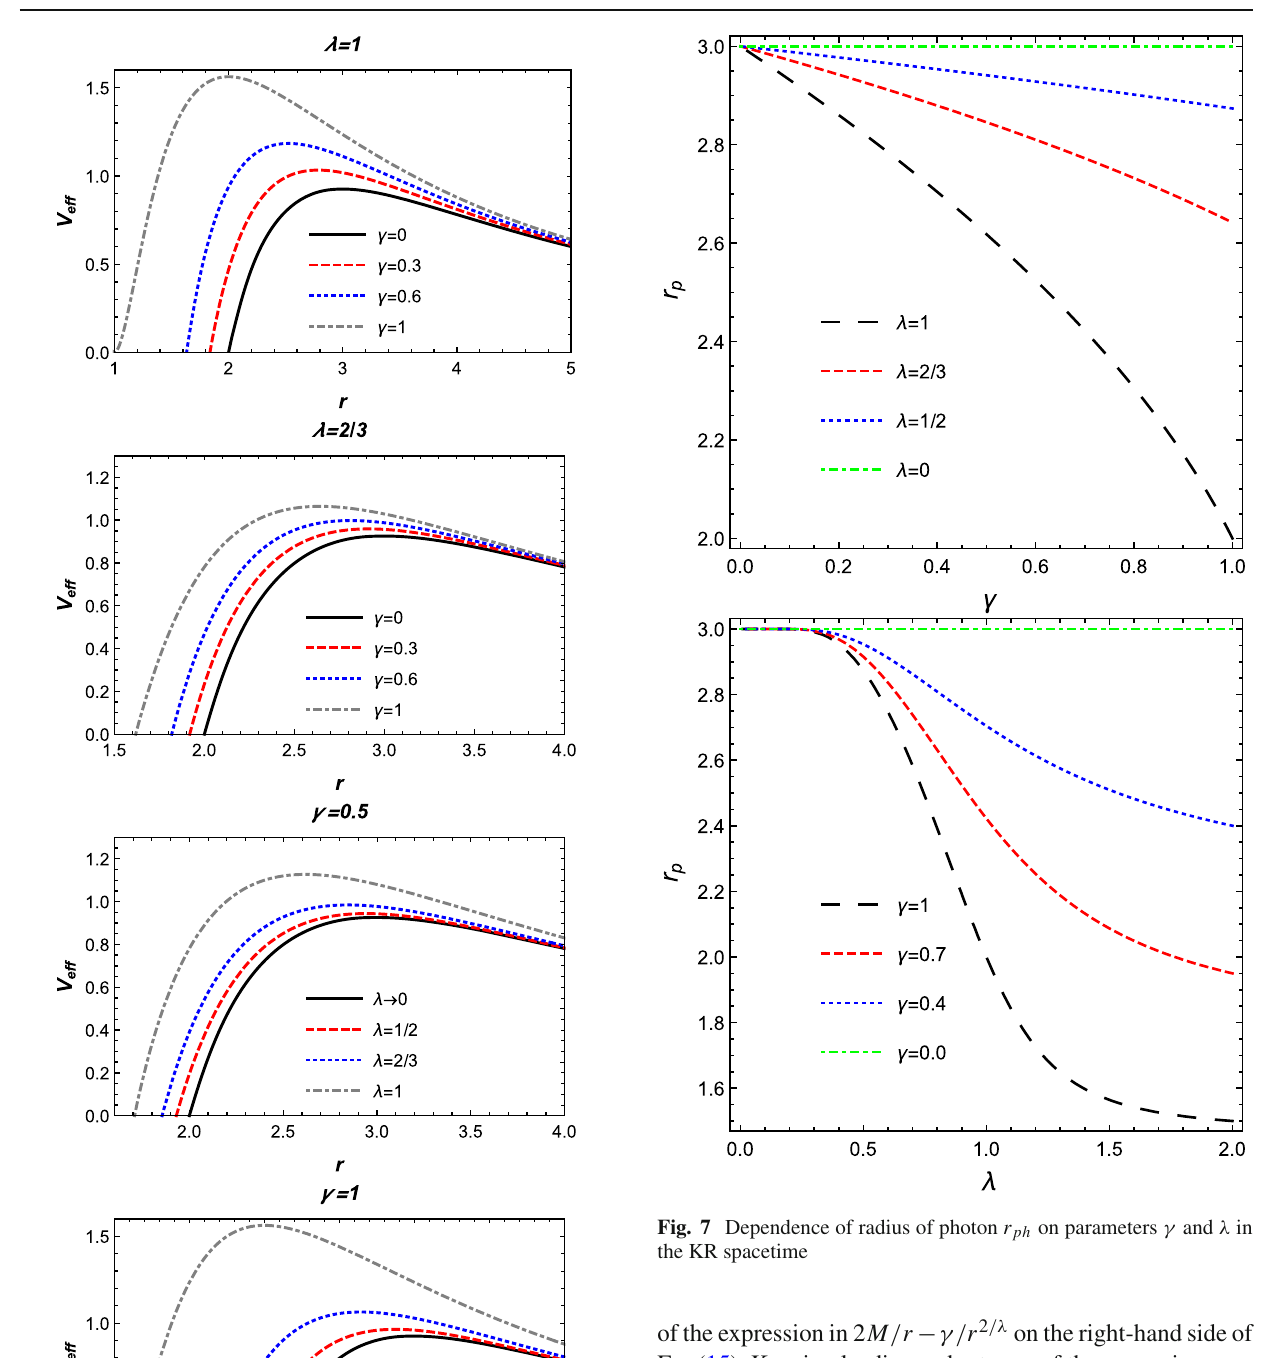
of the expression in 2 M / r − γ/ r 2 /λ on the right-hand side of Eq. (15). Keeping leading order terms of the expansion may obtain the following expression